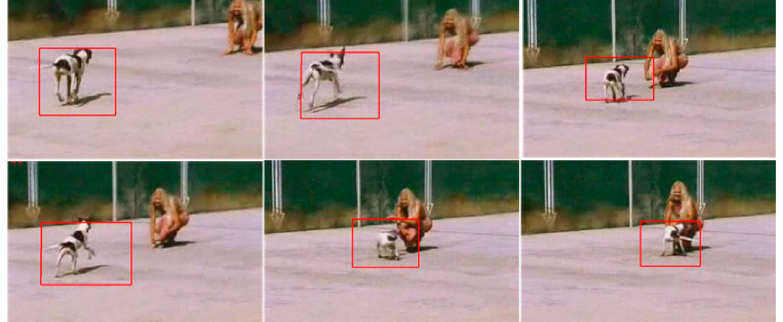
Figure 9. Tracking of a running dog (Data Set: Running Dog).